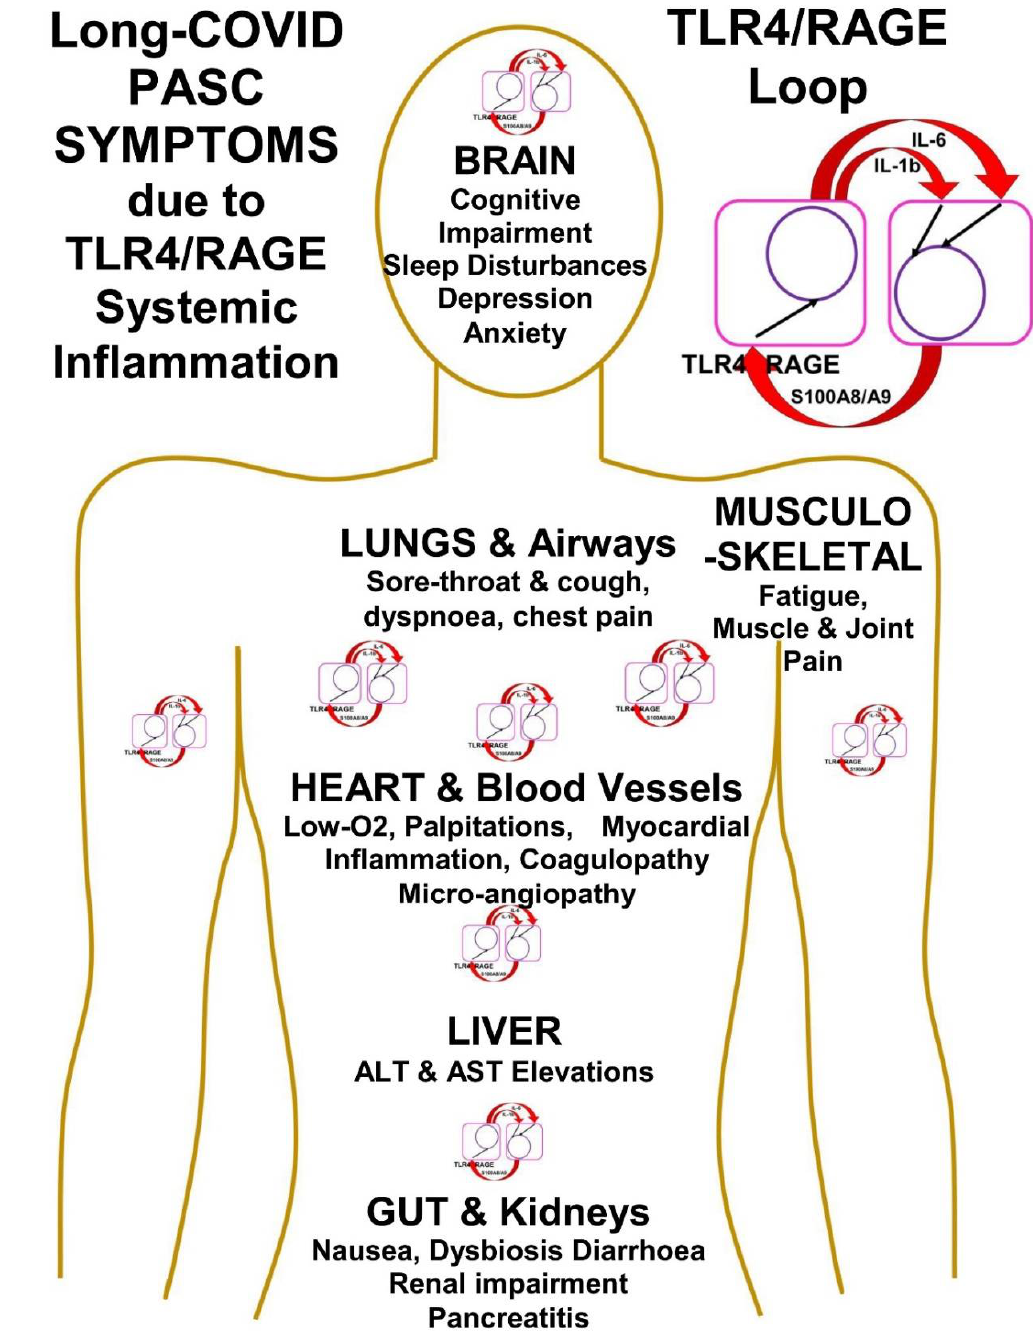
Figure 1. The TLR4/RAGE loop causes chronic secretion of pro-inflammatory cytokines IL-1b and IL-6, which act on IL-1R and IL-6R, to induce more RAGE and TLR4 and secretion of pro-inflammatory S100A8/A9. Chronic systemic inflammation driven by TLR4/RAGE Loop signalling gives rise to chronic symptoms and pathologies in all organ systems. Brain inflammation causes cognitive impairment, sleep disturbances, depression and anxiety. Lung and airway inflammation causes cough, sore throat, breathlessness, low oxygen saturation and chest pain. Inflammation in blood vessels and heart causes myocardial inflammation, coagulopathy and micro-angiopathy. Liver inflammation causes ALT and AST elevation. Inflammation in the gut causes nausea, dysbiosis, diarrhoea and pain. Inflammation also causes renal impairment and pancreatitis. Inflammation in the musculo-skeletal system causes fatigue, and aches and pains in muscles and joints.